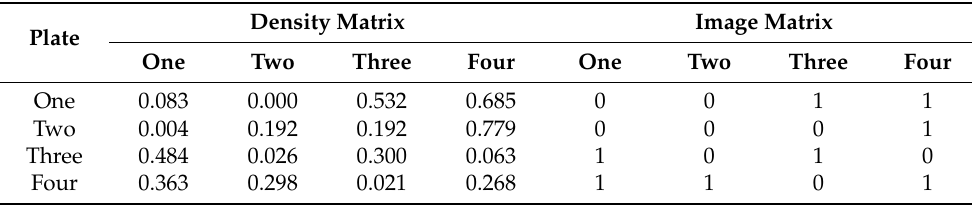
Table 7. Density or image matrix of eco-efficiency in Bohai Rim. Density Matrix Image Matrix Plate One Two Three Four One Two Three Four One 0.083 0.000 0.532 0.685 0 0 1 1 Three 0.484 0.026 0.300 0.063 0 Four 0.363 0.298 0.021 0.268 1 1 0